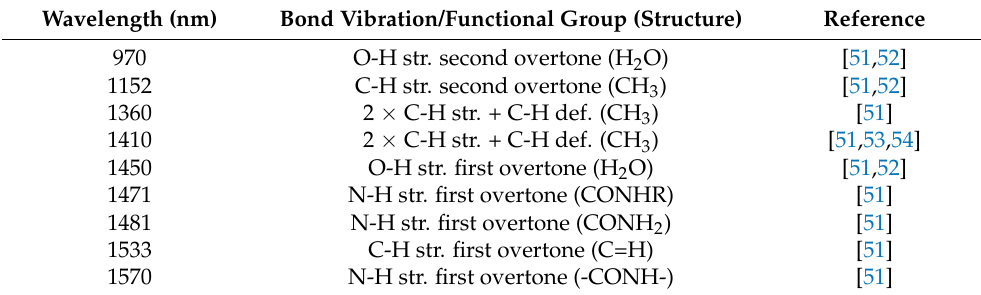
Table 6. Corresponding absorption bands from X-loading and regression coefficients.